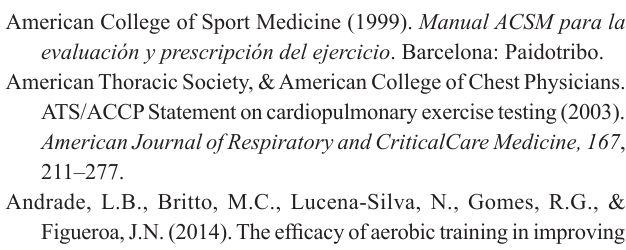
Figueroa, J.N. (2014). The efficacy of aerobic training in